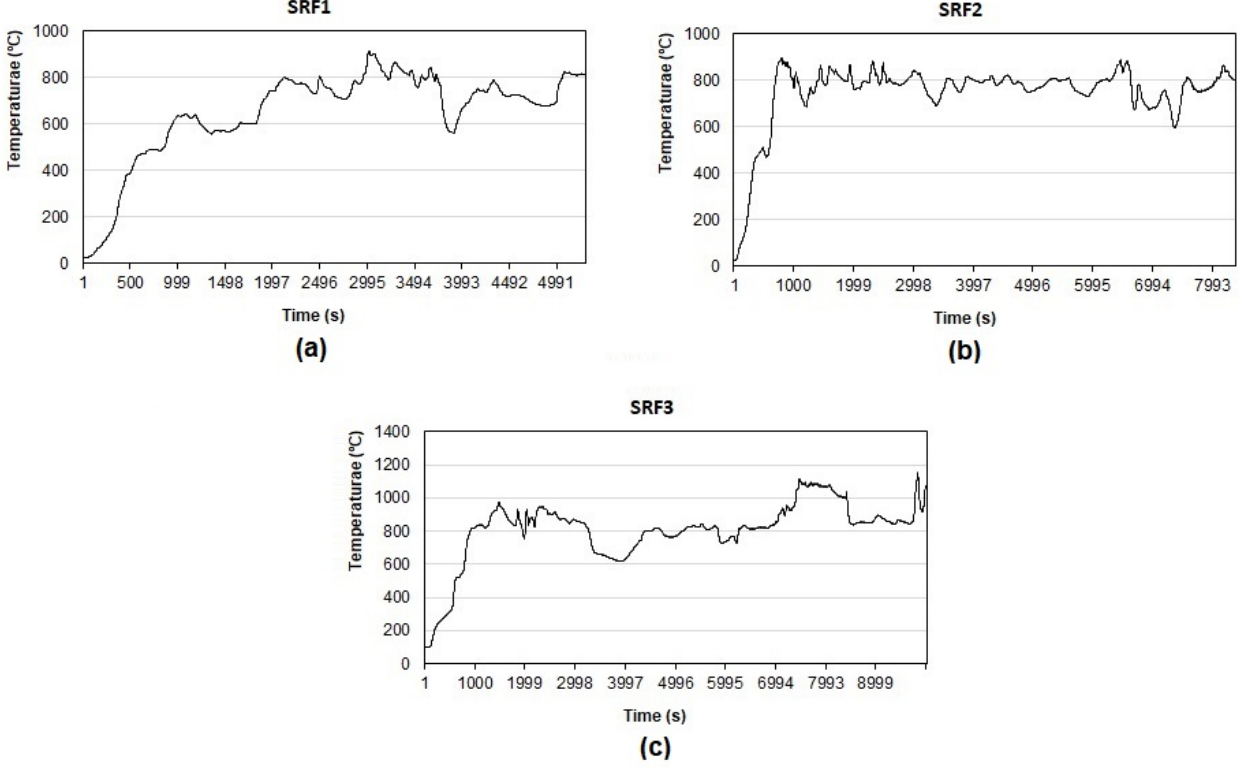
Figure 3. Temperature profiles over time for each gasification test using ( a ) SRF1, ( b ) SRF2 and ( c ) SRF3. ( c )